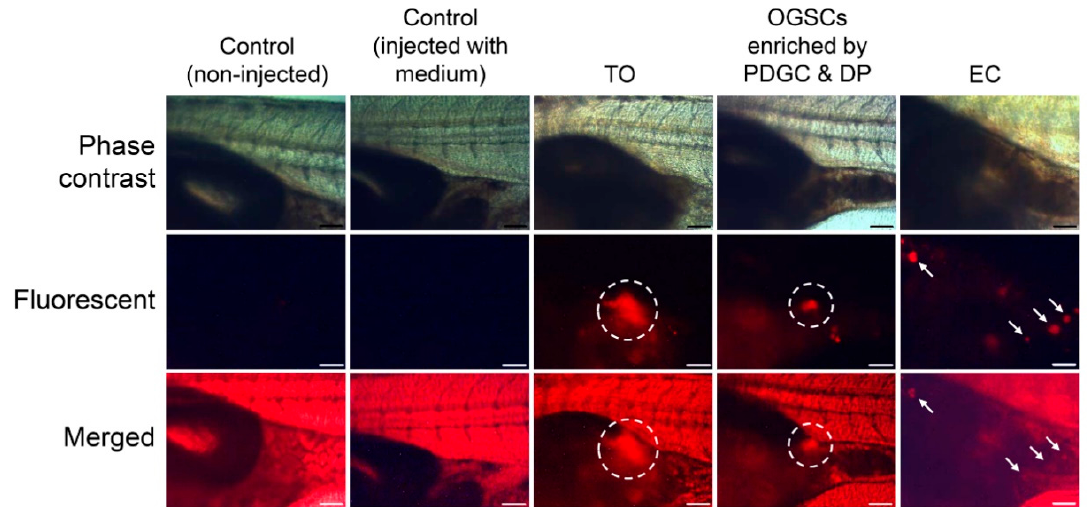
Figure 6. Transplantation assay of OGSCs. Crude TO was obtained from 10 adult females and enriched by PDGC and DP in combination. TO, enriched OGSCs, or Oryzias latipes EC were transplanted into a peritoneal cavity of larvae at 11 dpf after labeling with PKH26. Localization of the donor cells in the gonadal region of the recipient larvae was examined at 20 dpf (9 days post-transplantation). The localization of the cells (dotted circles) was observed in the recipient larvae transplanted with TO and the cells enriched by PDGC and DP. The recipients transplanted with EC showed ectopic fluorescent signals (arrows) scattered in posterior abdominal regions. Scale bar = 100 µm.